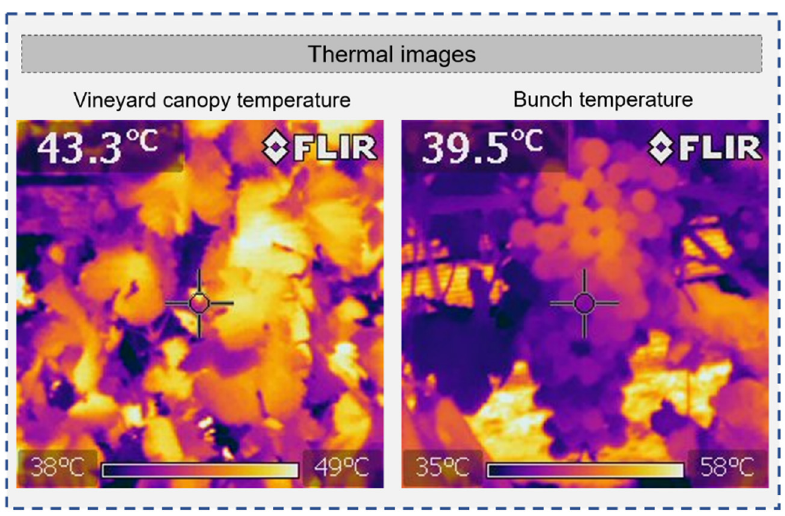
Figure 4. Thermal images of the vineyard canopy and bunches collected with a FLIR handheld ther- mal imaging camera in a hot arid climate